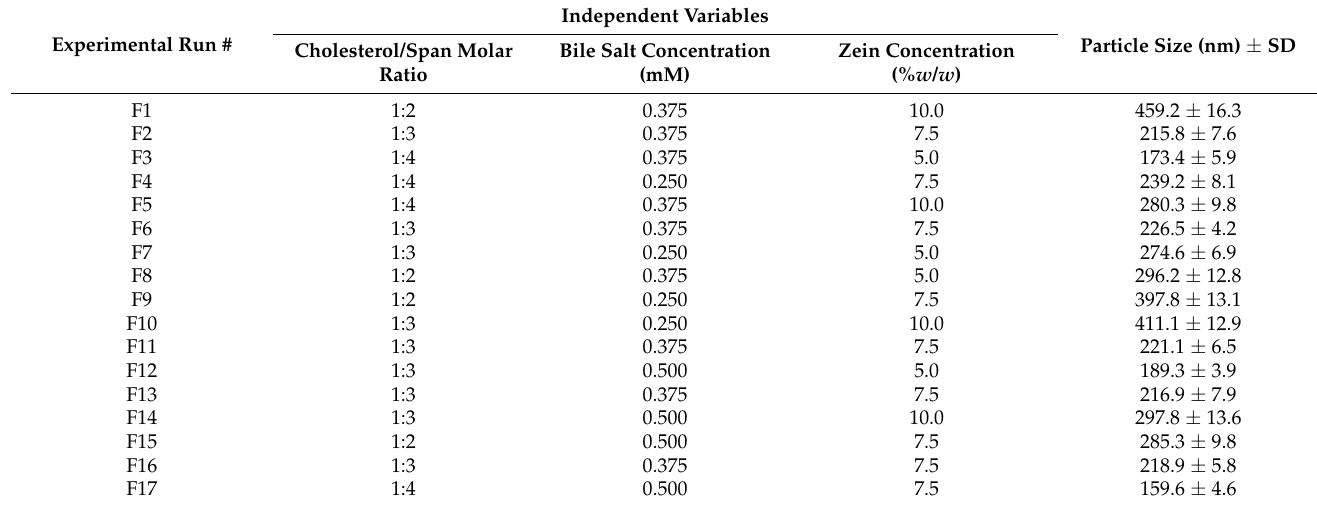
Table 2. Variables levels and observed particle size for PIC-BZ experimental runs prepared according to Box–Behnken design. Independent Experimental Run #